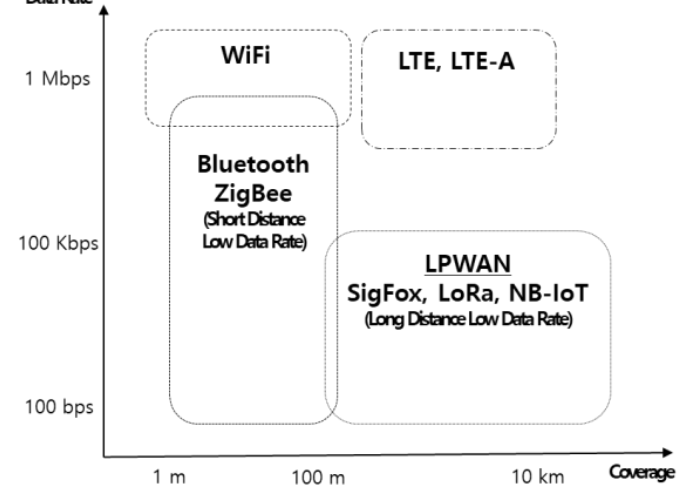
Figure 1. Types of Communication Methods [2].